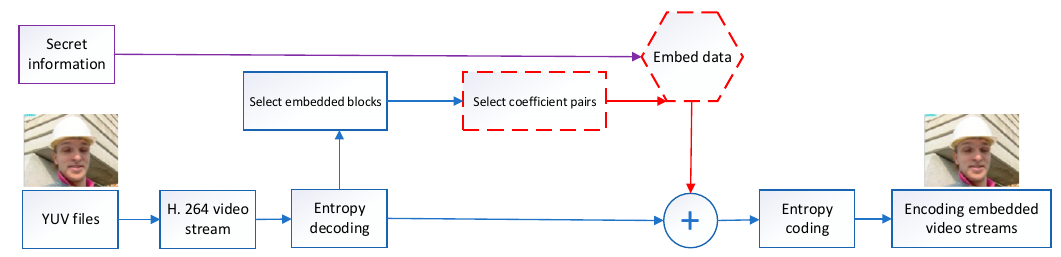
Figure 1. Flowchart of a reversible data hiding algorithm based on multiple histograms.